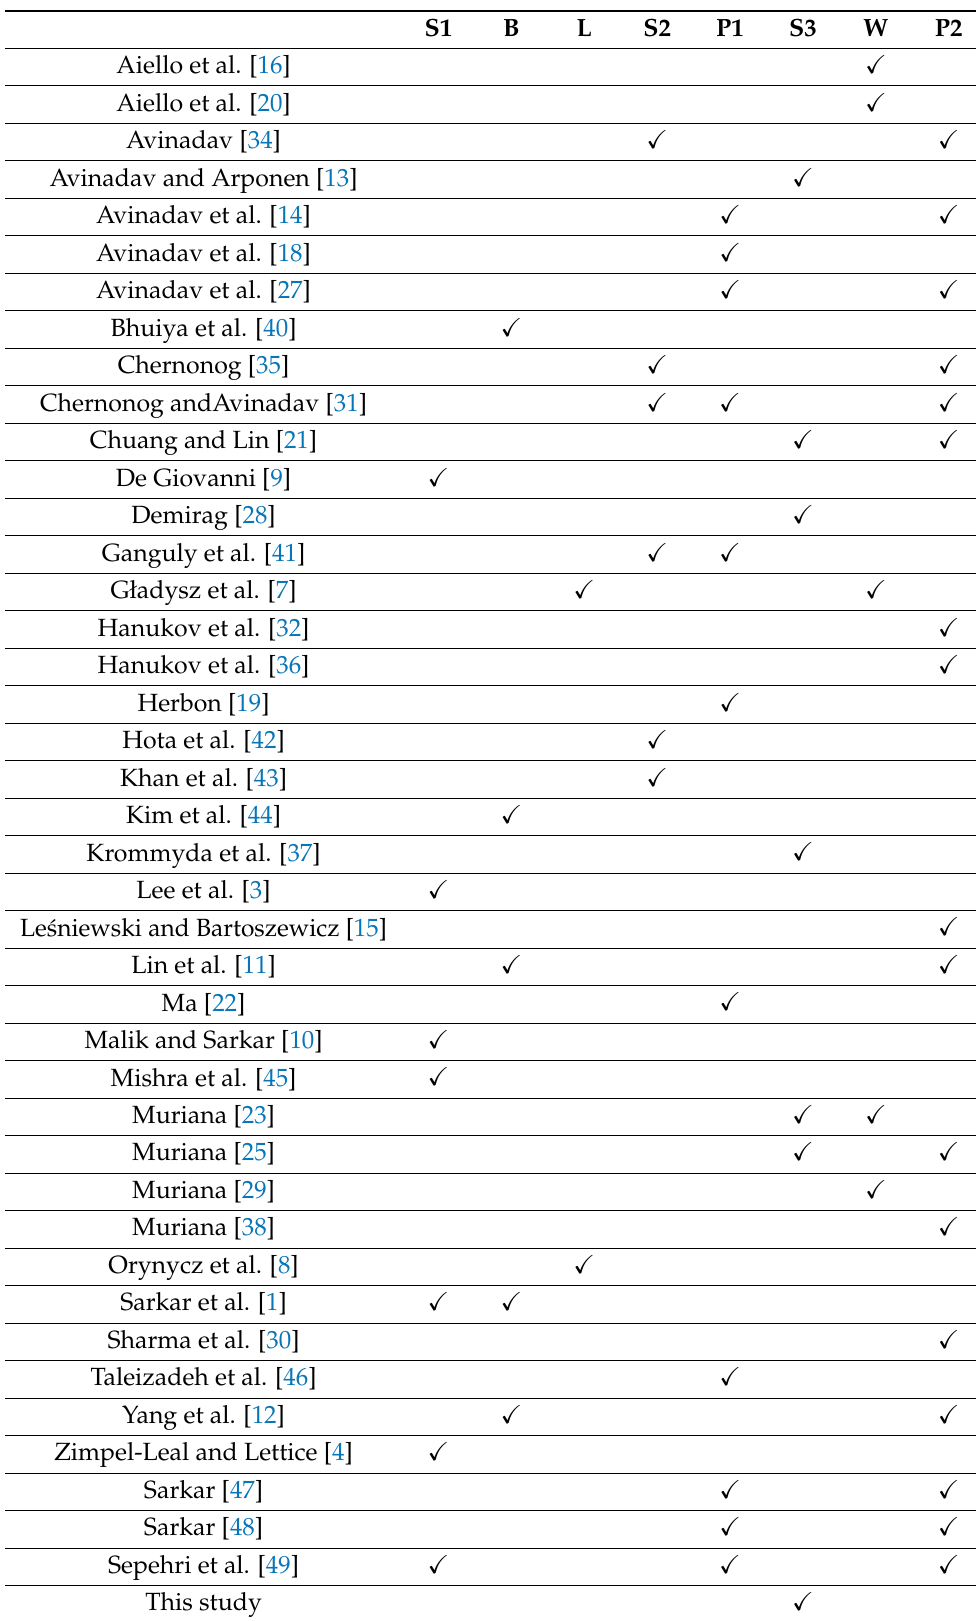
Table 1. Comparisons among